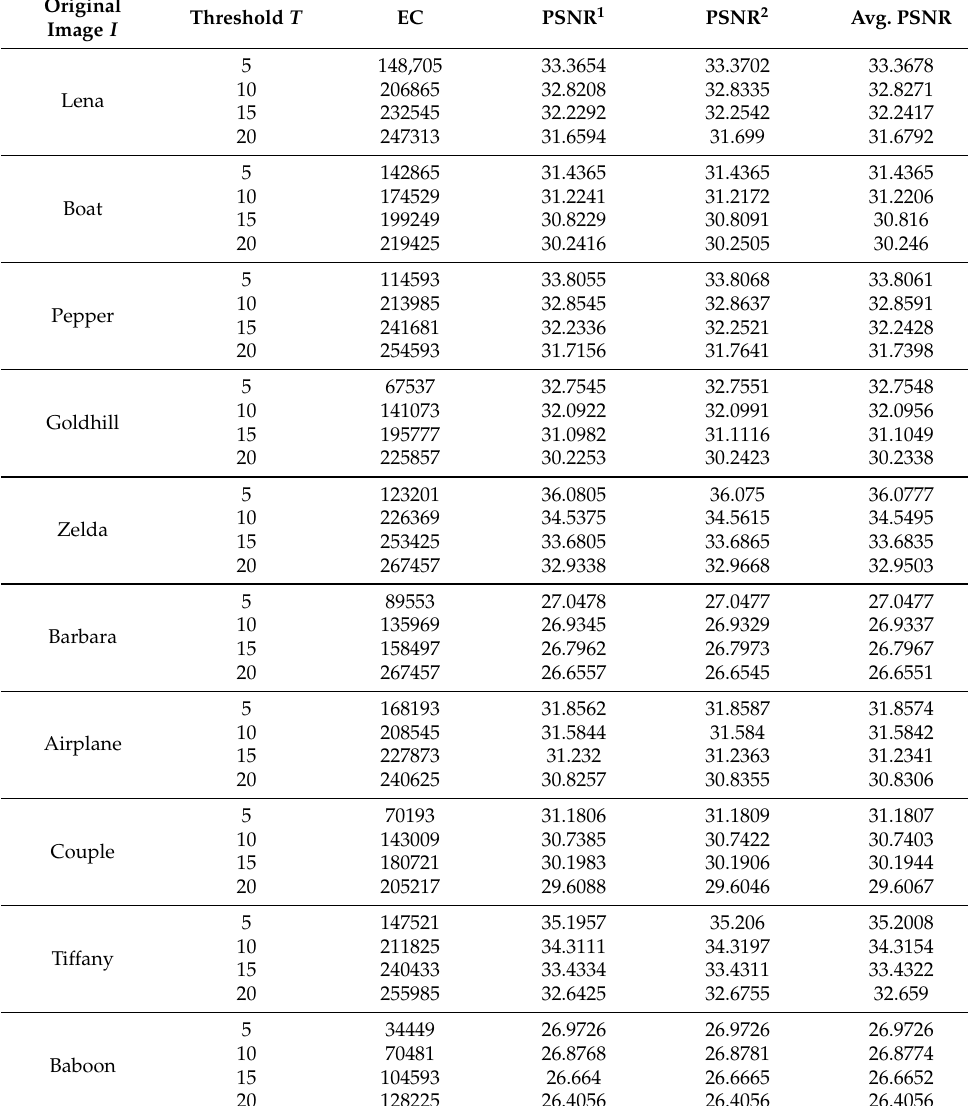
Table 2. PSNR of dual stego images with embedding capacity.